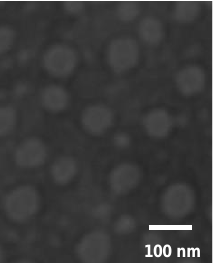
Figure 5. TEM micrograph of PTX-loaded mPEG-CS(SH)-CHO micelles.